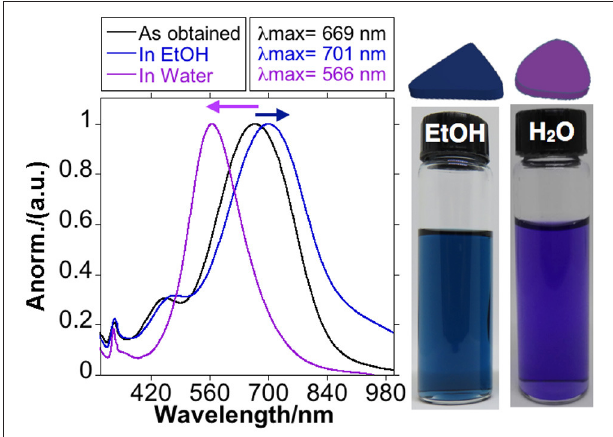
FIGURE 1 | Spectroscopic profile and color of AgNTs@PVP resuspended in EtOH (blue) or Water